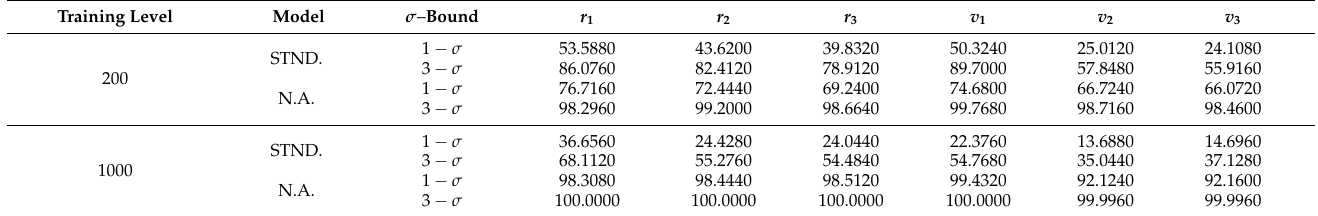
Table 6. Percentage of errors within σ –bound for standard and noise aware